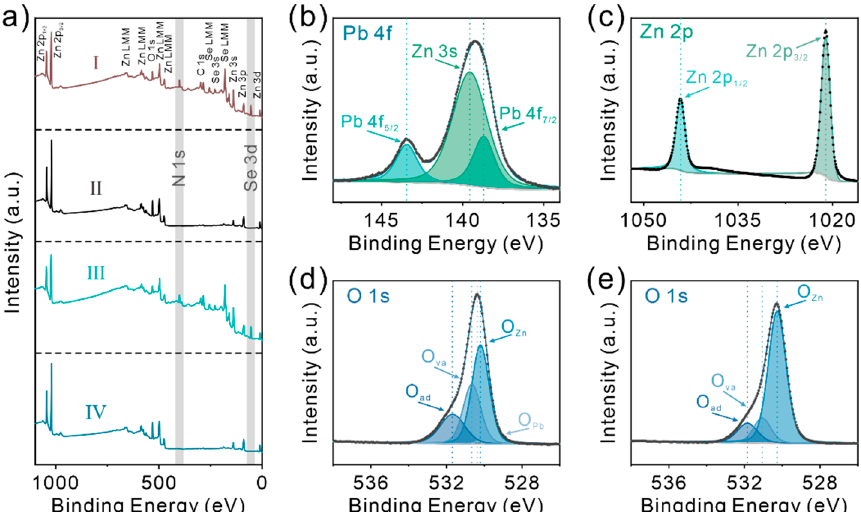
Figure 4. ( a ) The survey XPS spectra of the ZnSe·0.5N 2 H 4 precursor nanobelts before (I) and after ( Ⅱ ) thermal oxidation, and precursor nanobelts partially exchanged with 0.61 at% of Pb 2+ cations before ( Ⅲ ) and after ( Ⅳ ) thermal oxidation. The high resolution of XPS spectra in ( b ) Pb 4f, ( c ) Zn 2p and ( d ) O 1s for 0.61 at% Pb-doped ZnO porous nanobelts. ( e ) High-resolution XPS spectrum of O 1s for pure ZnO.